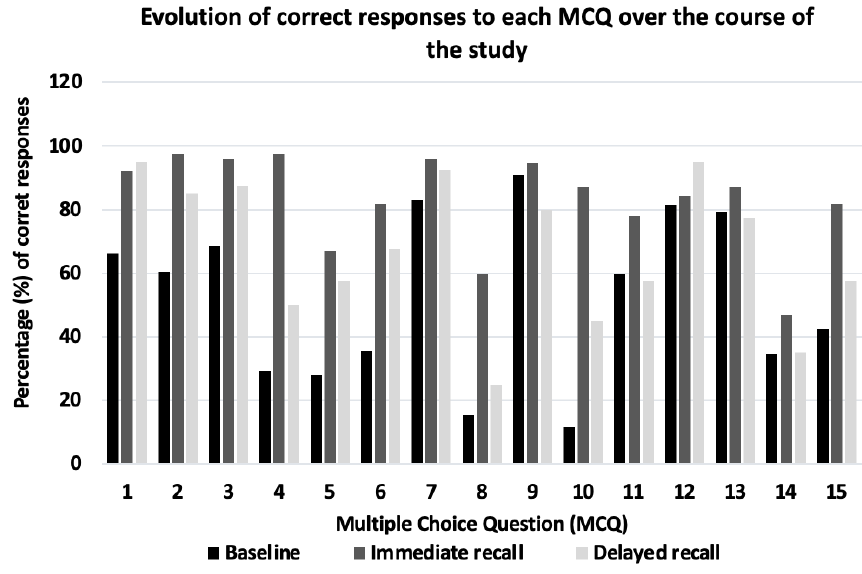
Figure 4. Percentage (%) of correct responses to each MCQ (1–15) over course of study. Before watching the video, 75.9% of students rated their confidence in recognising The number of correct responses fell for all questions on the DRQ except for MCQs 1 dystonia as low, and just 3.4% rated it as high. Immediately after watching the video, 78.3% rated their confidence as a high, and none rated it low (Figure 5); 72.5% of the students stated that they felt more confident in recognising cervical dystonia, whilst 47.5% felt more confident in recognising hand or facial dystonia.